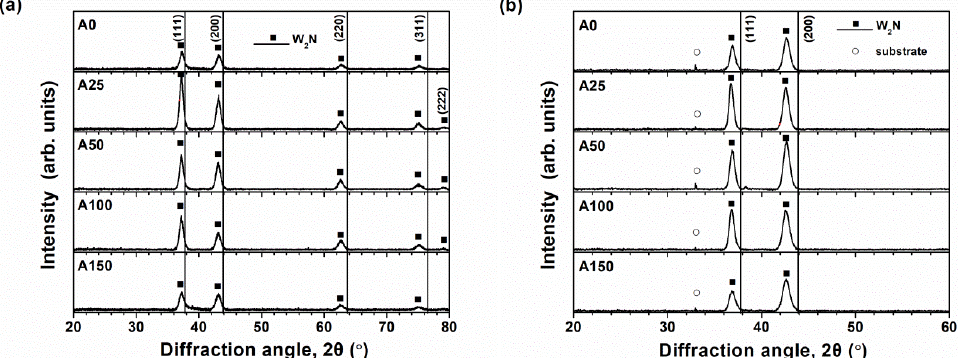
Figure 3. ( a ) Grazing incident and ( b ) Bragg–Brentano scan XRD patterns of the Batch A films.